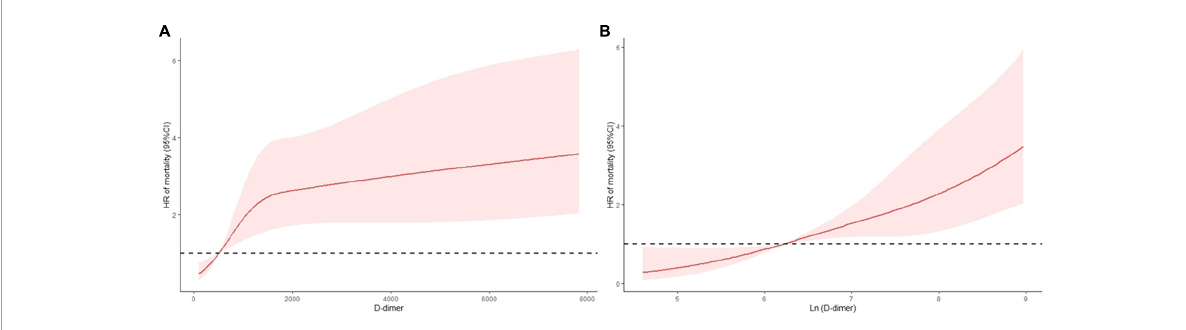
predicted 30-day mortality and compared it with the actual observations ( Figure 3 ). The average predicted mortality of the high D-dimer level was well-matched with the observed mortality. A similar result was observed for the median and low D-dimer cohorts, and the rates of concordance